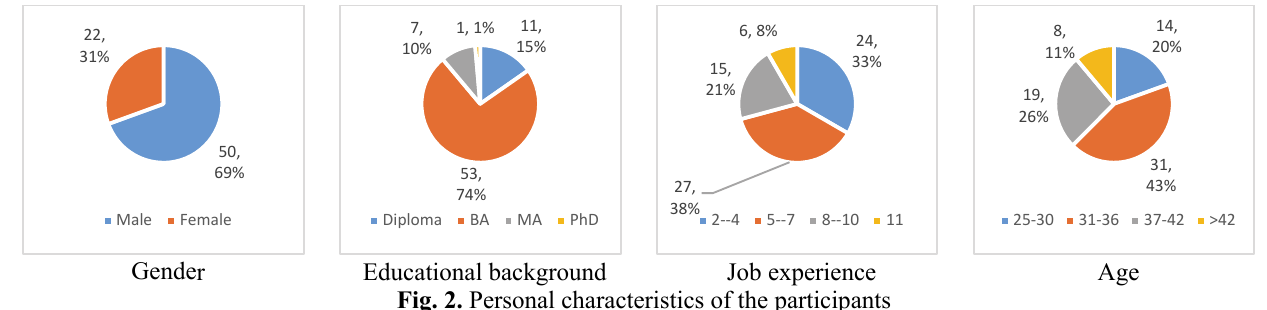
Fig. 2. Personal characteristics of the